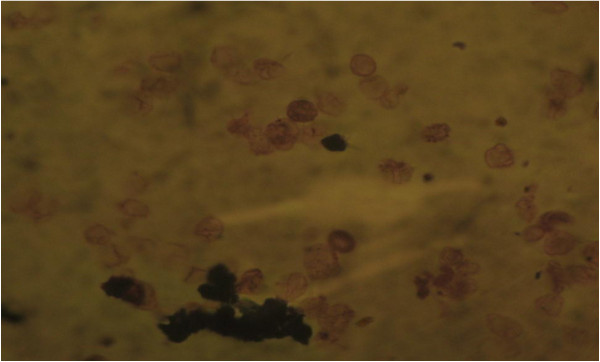
Picture of sickle cell patient blood treated with Solenostermon monostachyus (Magnification: x1000).